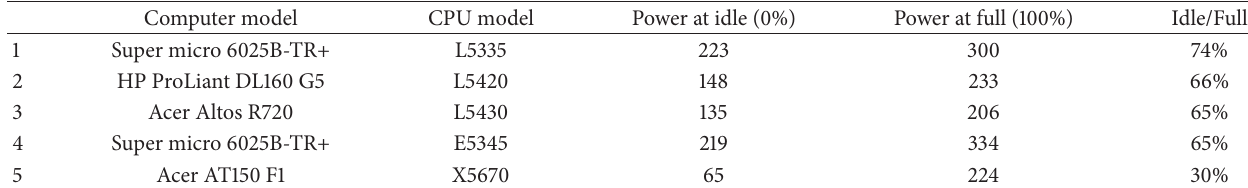
Table 1: Percentage of power consumption in idle and full CPU